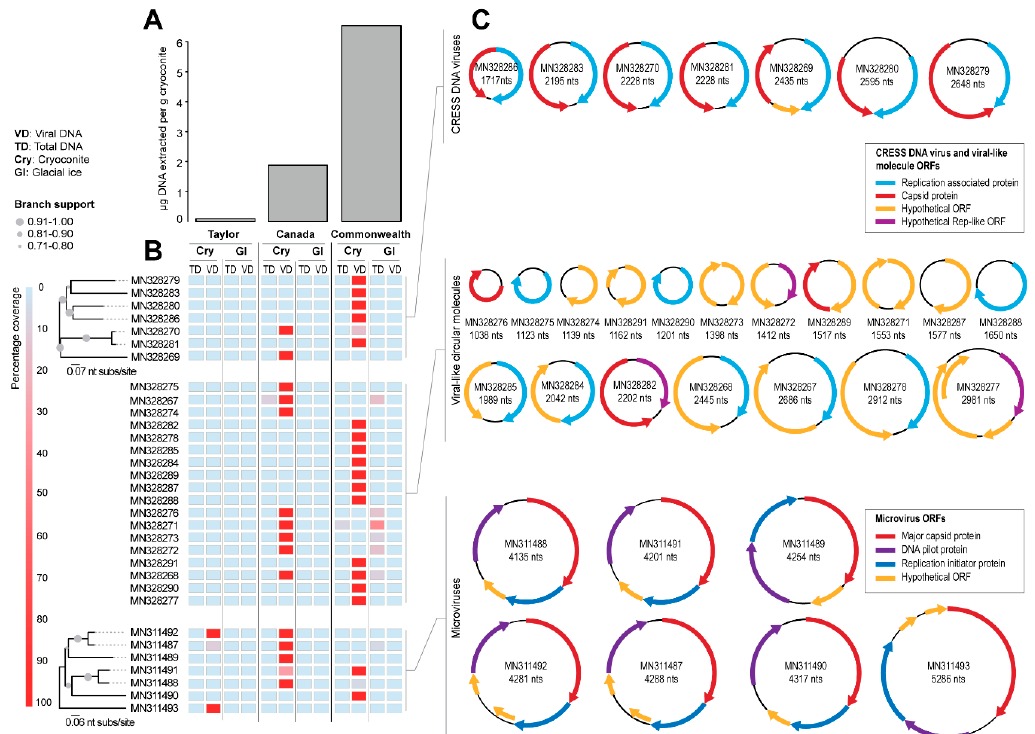
Figure 2. ( A ) : Total DNA concentrations extracted from cryoconite hole samples from the Taylor, Canada and Commonwealth glaciers for the amplicon sequencing performed in Sommers et al. [22] .